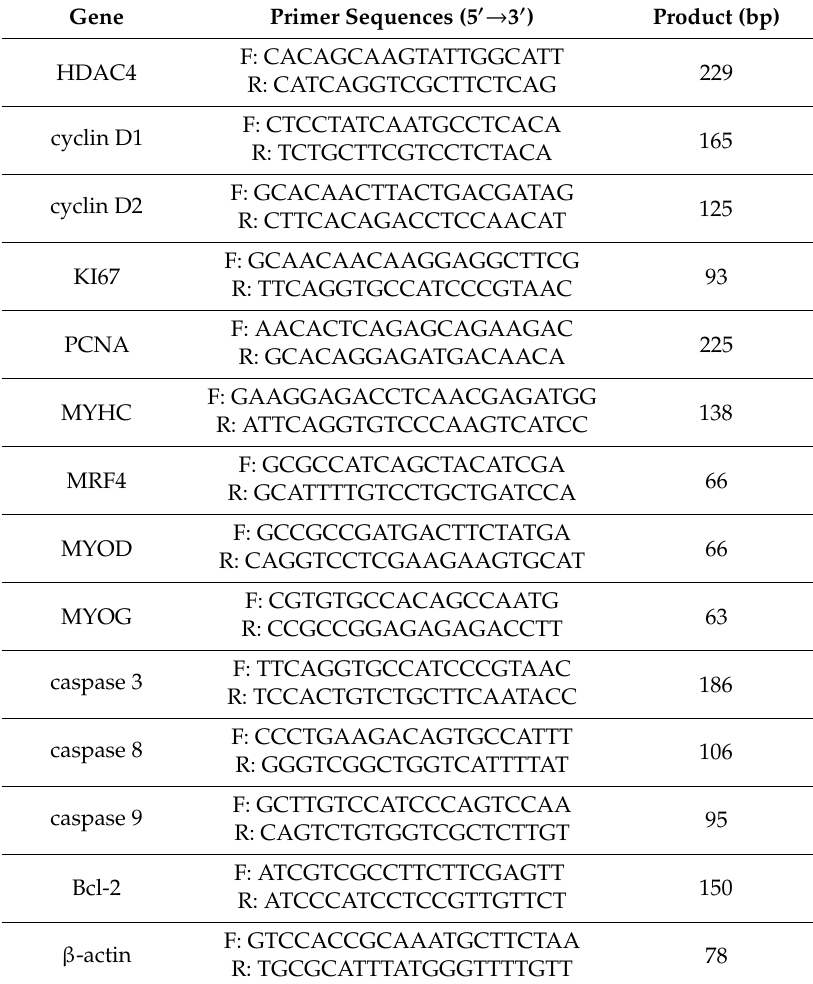
Table 2. Primers for